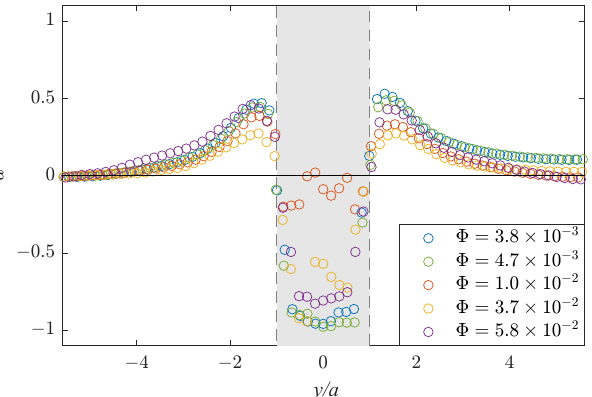
Figure 7. Profiles of the normalized longitudinal velocity ˆ u along the y -axis for the obstacle height H / G = 0.78 and the liquid fractions Φ = 3.8 × 10 − 3 (blue), 4.7 × 10 − 3 (green), 1.0 × 10 − 2 (red), 3.7 × 10 − 2 (yellow) and 5.8 × 10 − 2 (purple).